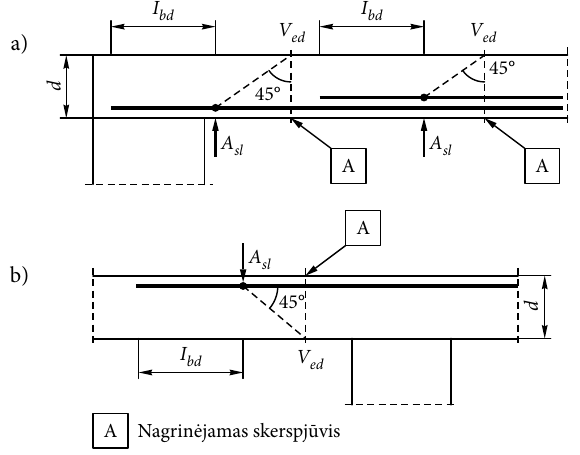
Fig. 2. The scheme of choice of longitudinal reinforcement design cross-section area A